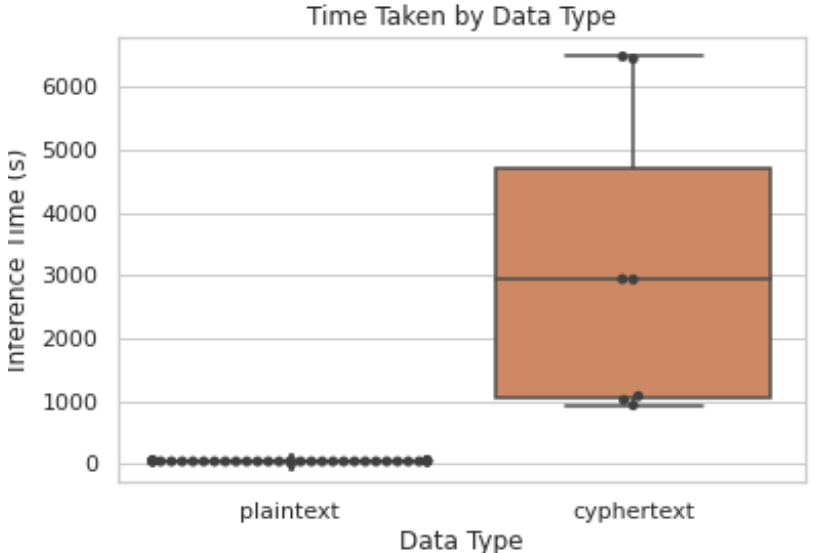
Figure 11. Model inference time by different types. Plaintext types mean where the graph is run using plaintext data. Cyphertext types mean where the graph is run using cyphertext data. Both plaintext and cyphertext data conforms to the same NumPy API, meaning they can be used interchangeably. Each dot is a different network (i.e., differently initialised weights but the same structure) or the same network with a different data type (cyphertext, plaintext)